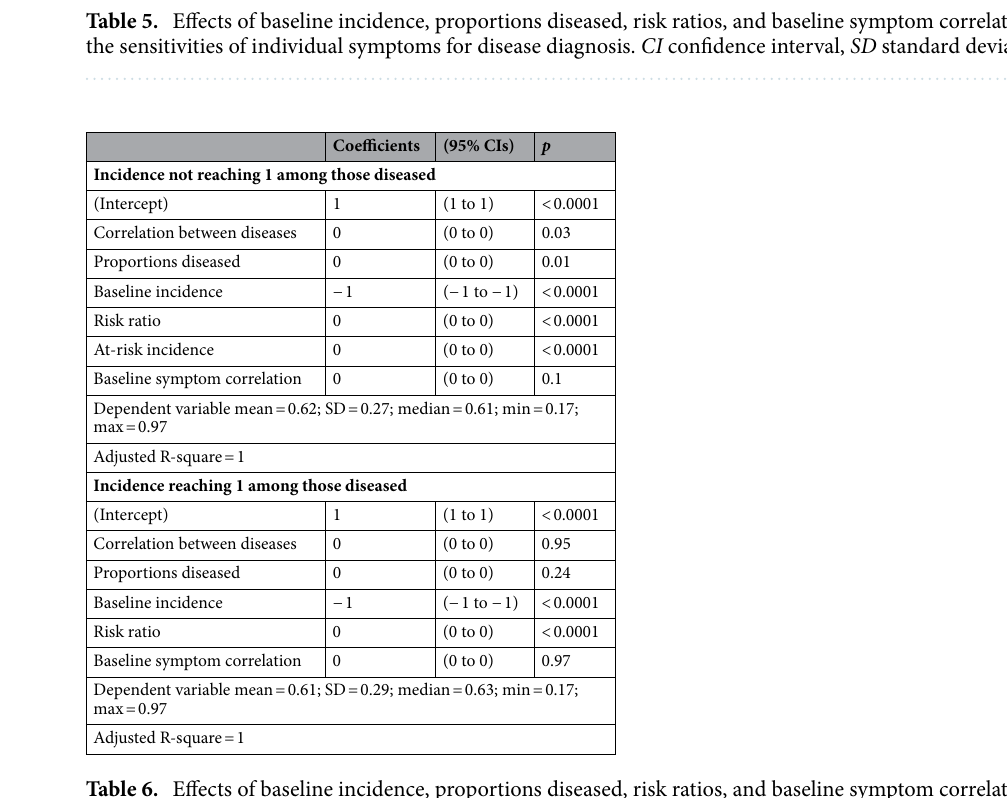
Table 6. Effects of baseline incidence, proportions diseased, risk ratios, and baseline symptom correlations on the specificities of individual symptoms for disease diagnosis. CI confidence interval, SD standard